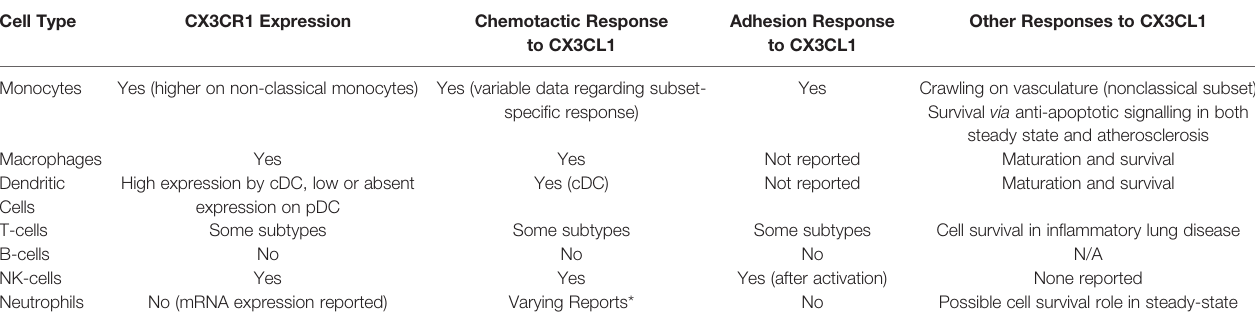
TABLE 1 | Summary of expression of CX3CR1 and chemotactic, adhesive and other physiological responses to CX3CL1 in major immune cell subtypes. Cell Type